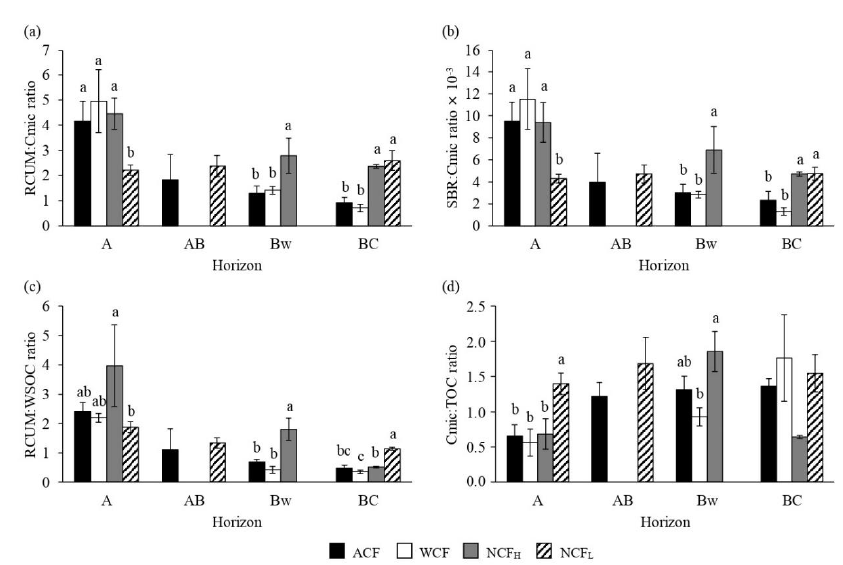
Figure 6. RCUM:Cmic ( a ), SBR:Cmic ( b ), RCUM:WSOC ( c ) and Cmic:TOC ( d ) ratios of soils under an abandoned chestnut forest (ACF), a chestnut forest for wood production with a tree density of 151 plants ha –1 (WCF), a chestnut forest for nut production with a tree density of 120 plants ha –1 (NCF H ) and a chestnut forest for nut production with a tree density of 98 plants ha –1 (NCF L ). Error bars are the standard errors. Within each horizon, different letters indicate significant differences by Tukey’s t -test p ≤ 0.05. RCUM = cumulative amount of CO 2 -C evolved during 21-days incubation experiment; SBR = soil basal respiration; WSOC = water-soluble organic carbon content; TOC = total organic carbon content.